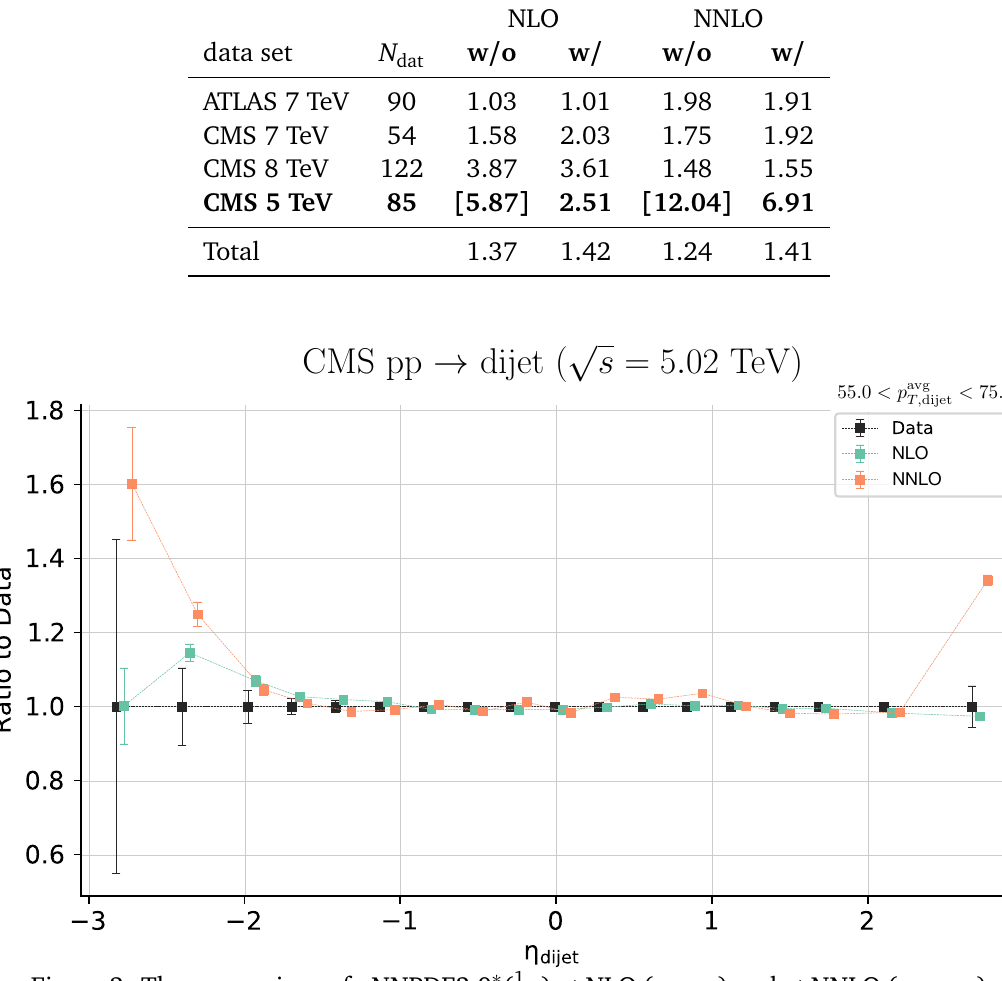
Figure 2: The comparison of nNNPDF2.0 ∗ ( 1 p ) at NLO (green) and at NNLO (orange) with fitted CMS 5 TeV pp dijet spectra to the data (black), all normalised to the data